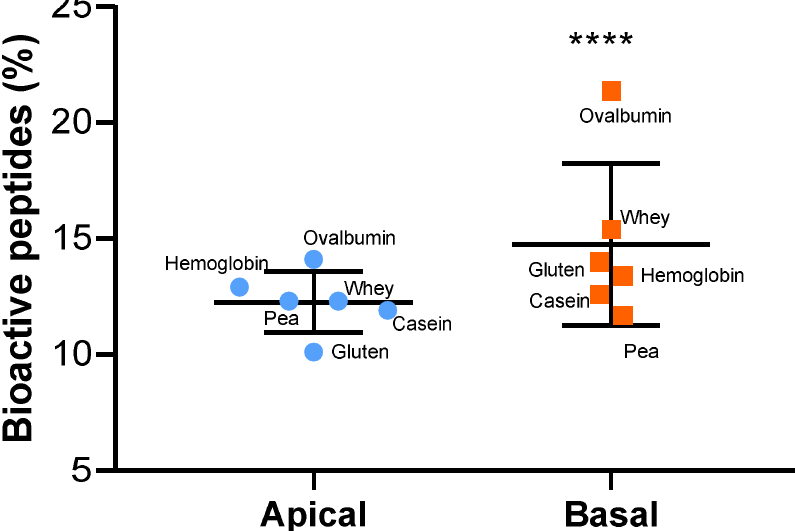
Figure 7. The richness in potential DPP-IV-inhibitory peptides increases during the IB transfer. The values are the percentage of bioactive peptides (with predicted DPP-IV IC 50 < 300 µ g · mL − 1 ) for each experimental condition in each compartment (apical/basal). The statistical analysis was performed using a one-sample t test (**** p < 0.0001) between the basal and apical means.